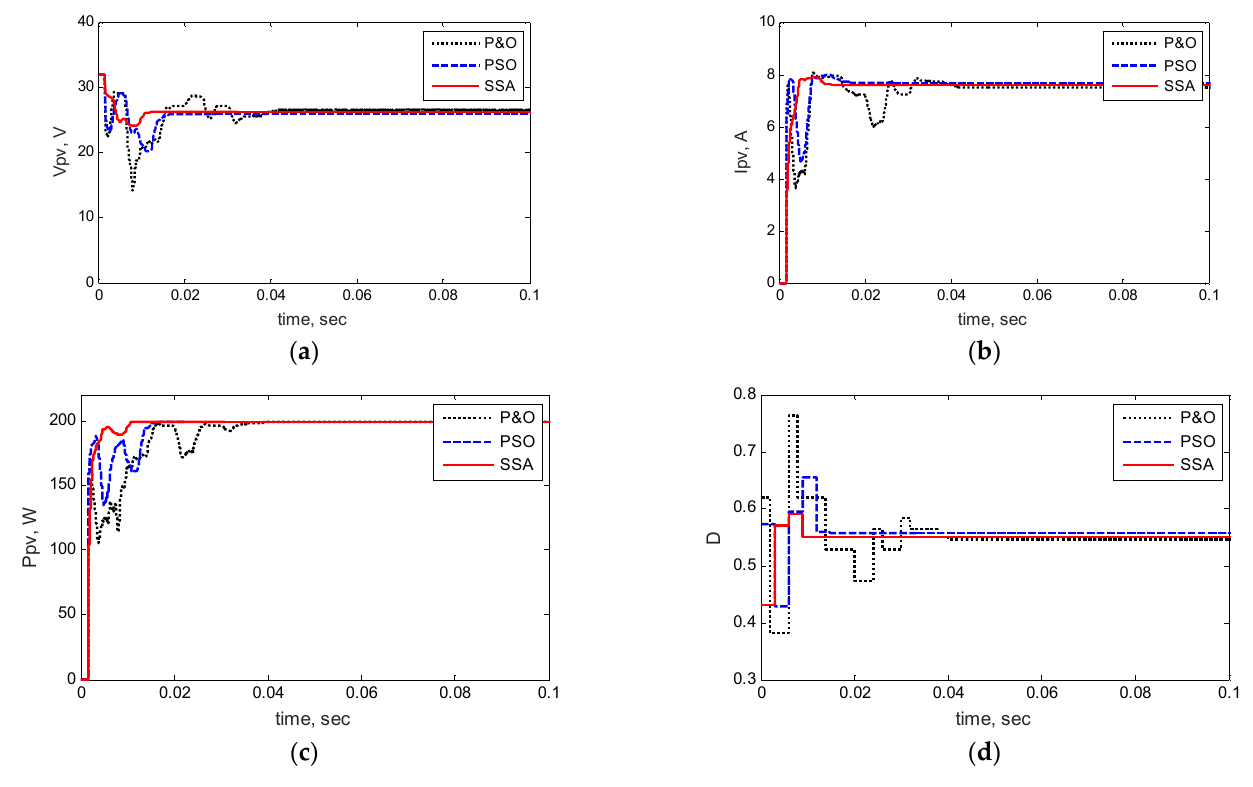
Figure 7. Photovoltaic panel tracking curves using the proposed method and P&O and PSO methods in STC conditions: ( a ) Vpv, ( b ) Ipv, ( c ) Ppv, ( d ) duty cycle.